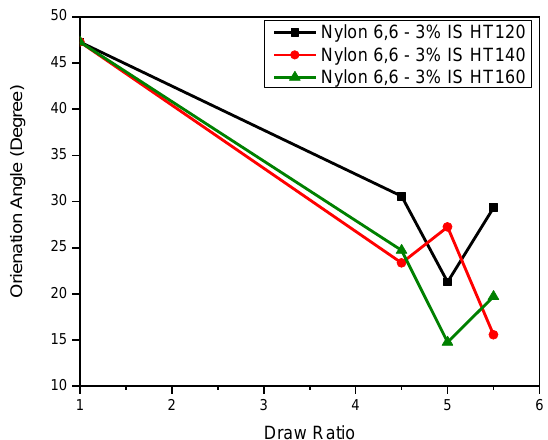
Figure 6. Azimuthal angle of as-spun and drawn neat ( a ) and salt-confined ( b ) nylon 6,6 fibres at different drawing ratio at drawing temperature of 140 °C.